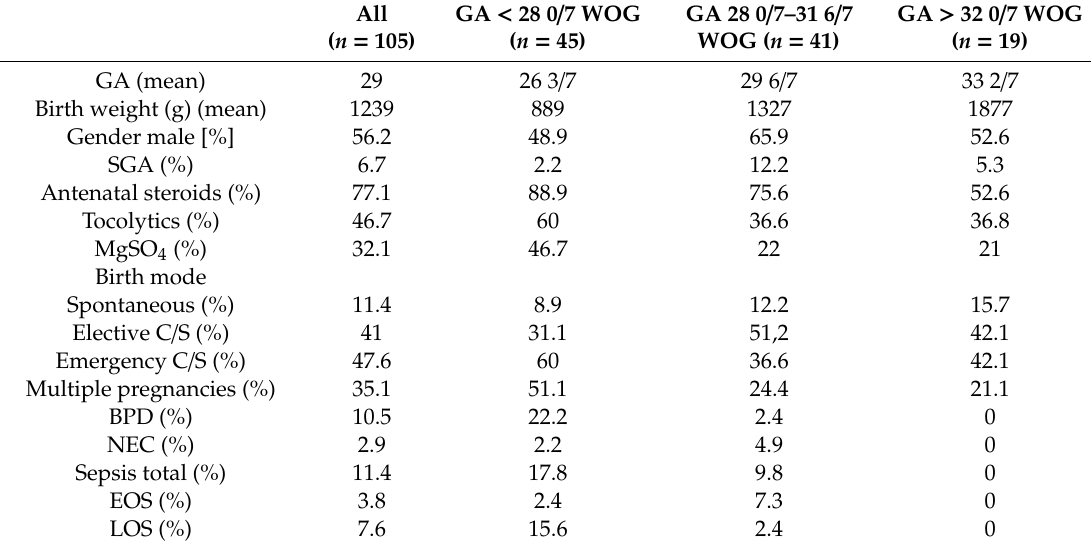
Table 1. Infant characteristics of the study